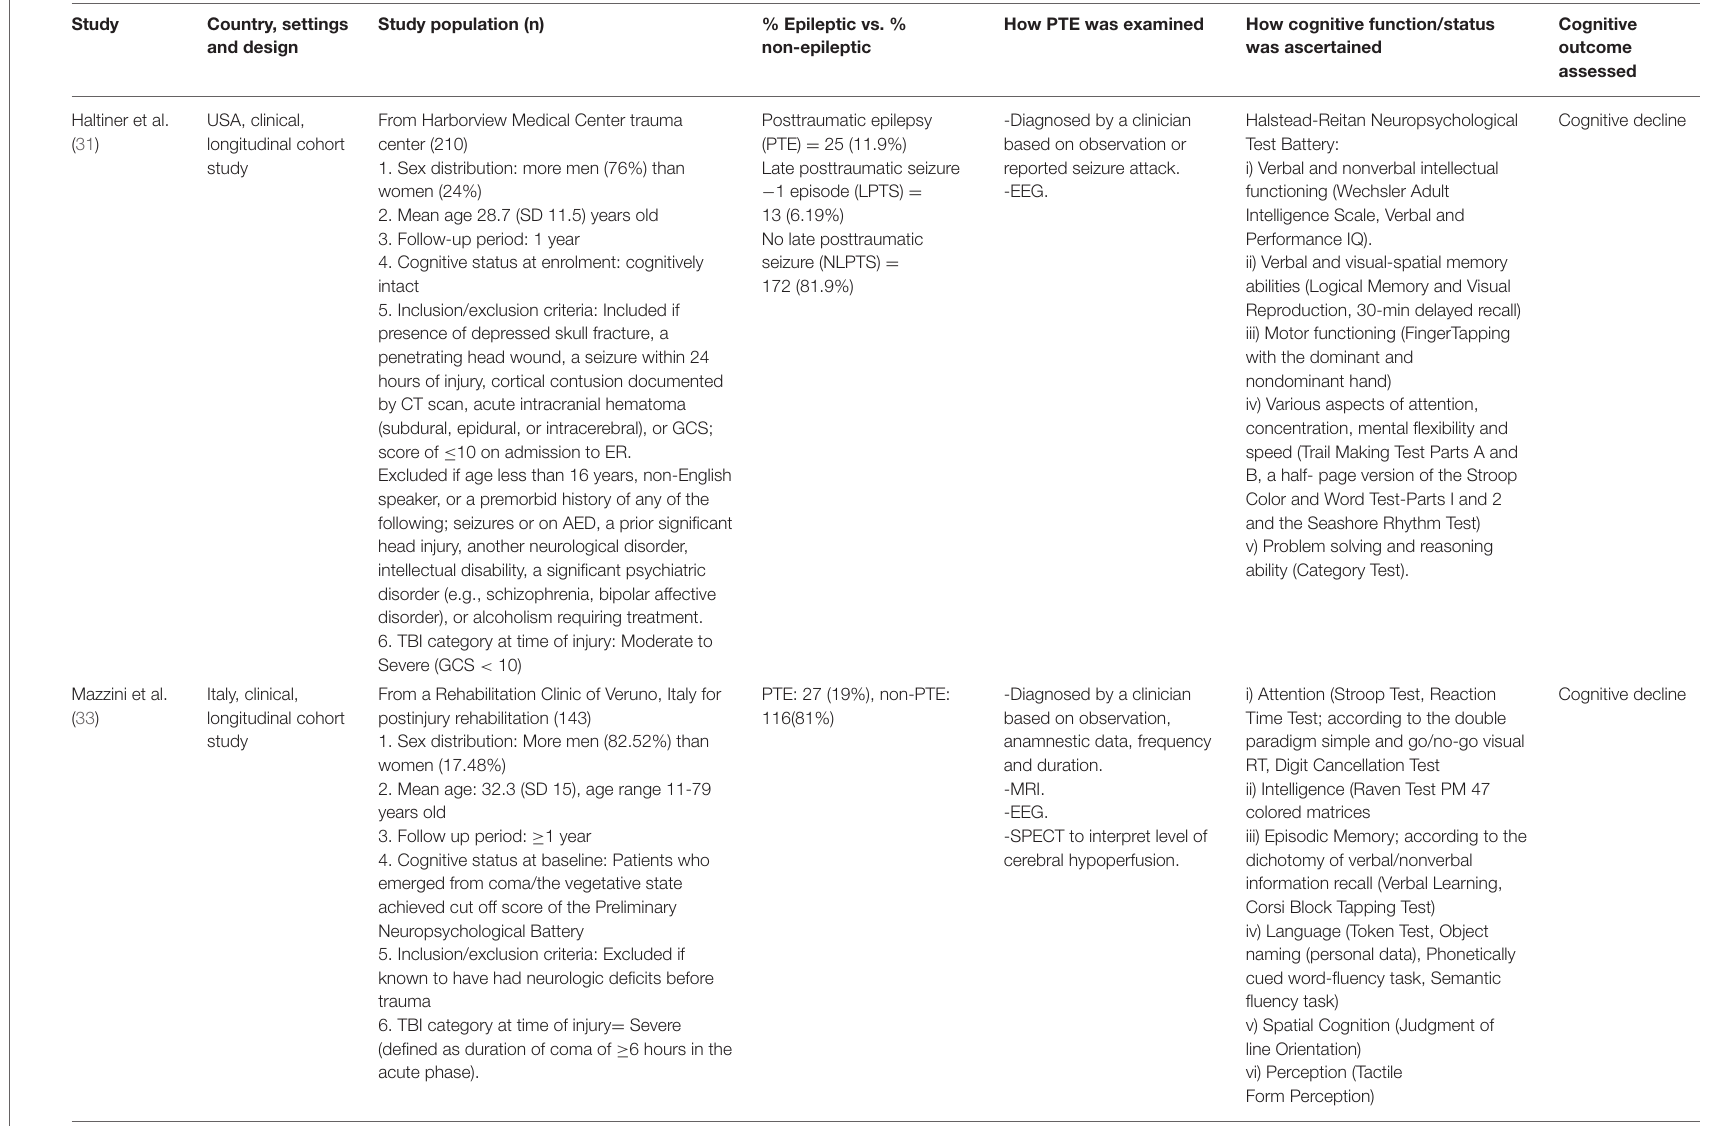
TABLE 1 | Characteristics of reviewed studies.